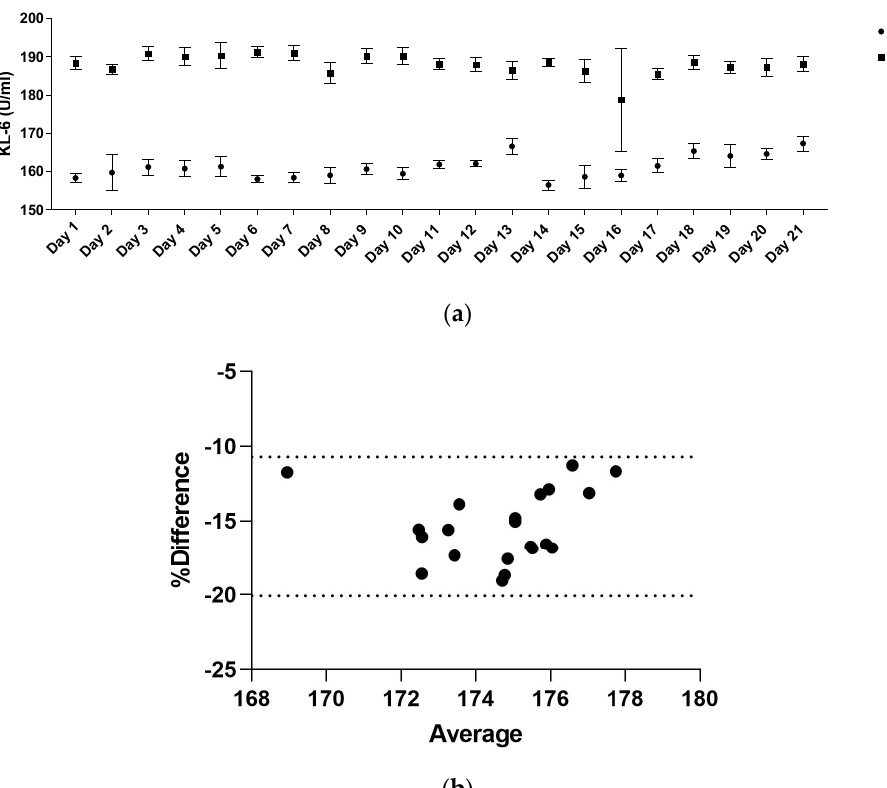
Figure 4. ( a ) the linearity of L1 and L2 reagent concentrations by Fujirebio analysed on AIA360 instrument. ( b ) Bland–Altman analysis for L1 and L2 concentrations for assessing agreement and Bias between